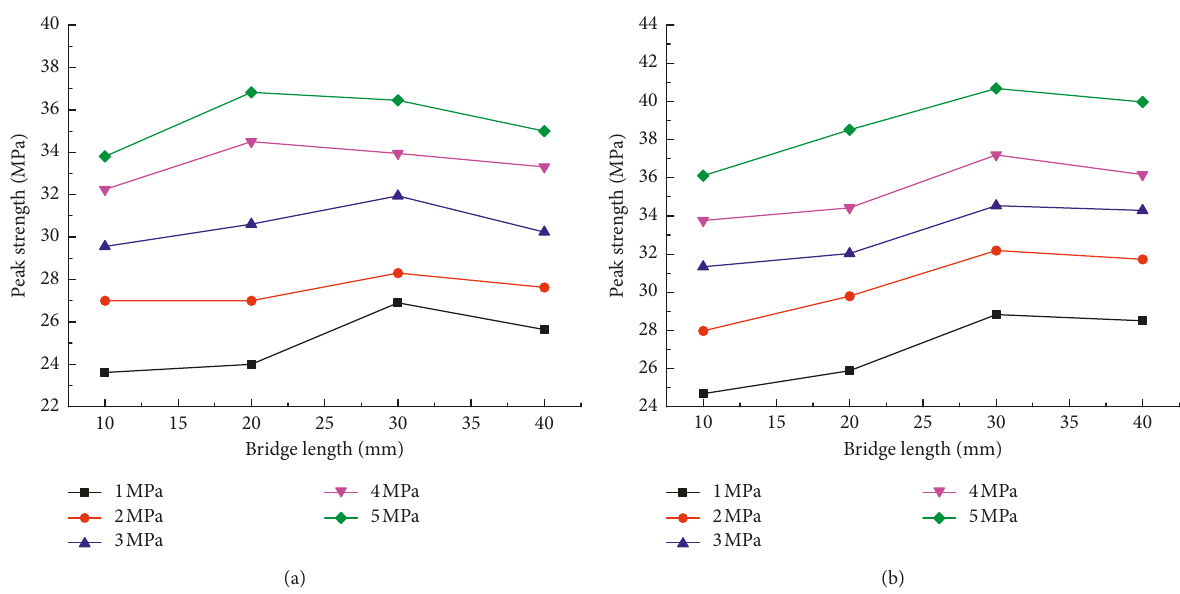
Figure 11: Peak strength of the specimens (a) 2 b -0-60-60 and (b) 2 b -30-60-60 having different bridge lengths.